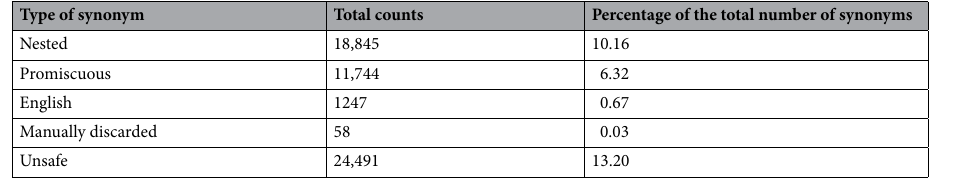
Table 1. Gene synonyms are ambiguous. Manually discarded synonyms were labelled as unsafe during the unsafe gene synonym detection in an active learning fashion (see Methods). Unsafe aggregates the data from all the other categories. Data for 19,082 gene symbols and 185,549 gene synonyms. The total counts represent the number of individual synonyms when grouped by gene symbol and gene synonym. Promiscuous synonyms are counted as many times as they act a synonym.